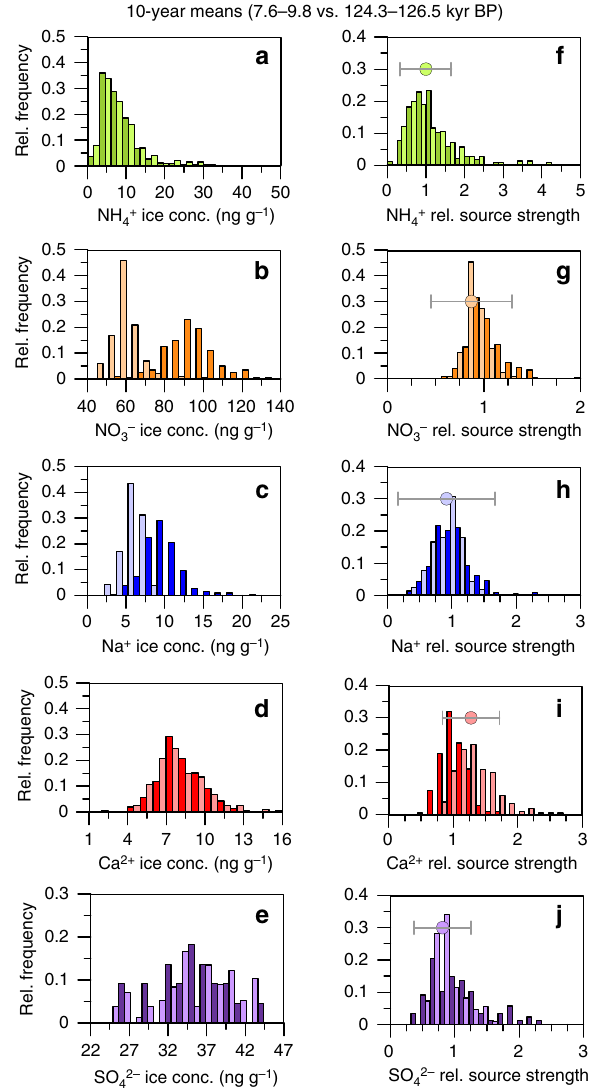
Fig. 3 Comparison of Eemian and Holocene concentrations. Histograms of 10-year means in the concentrations in the ice for a NH 4 + , b NO 3 − , c Na + , d Ca 2 + , and e SO 4 2 − for the early Holocene reference period (dark colors) and the Eemian reference period (light colors). f – j shows histograms of the reconstructed source concentration for these aerosol species in 10 year resolution relative to the early Holocene mean for the early Holocene reference period (dark colors) and the Eemian reference period (light colors). The dots indicate the median of the reconstructed relative source concentrations for the Eemian period. The error bars indicate the median of the uncertainty of the calculated relative source concentrations, where